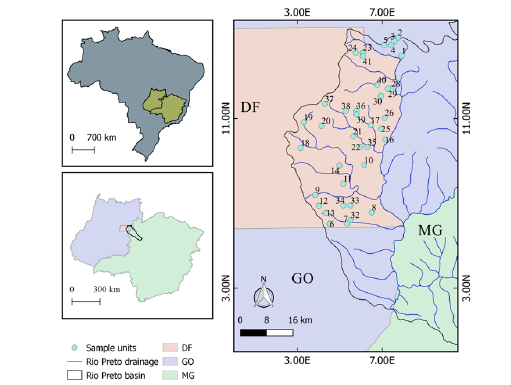
Figure 1. Locations of water reservoirs in the Rio Preto River Basin. Minas Gerais (MG), Goiás (GO), and Distrito Federal (DF)